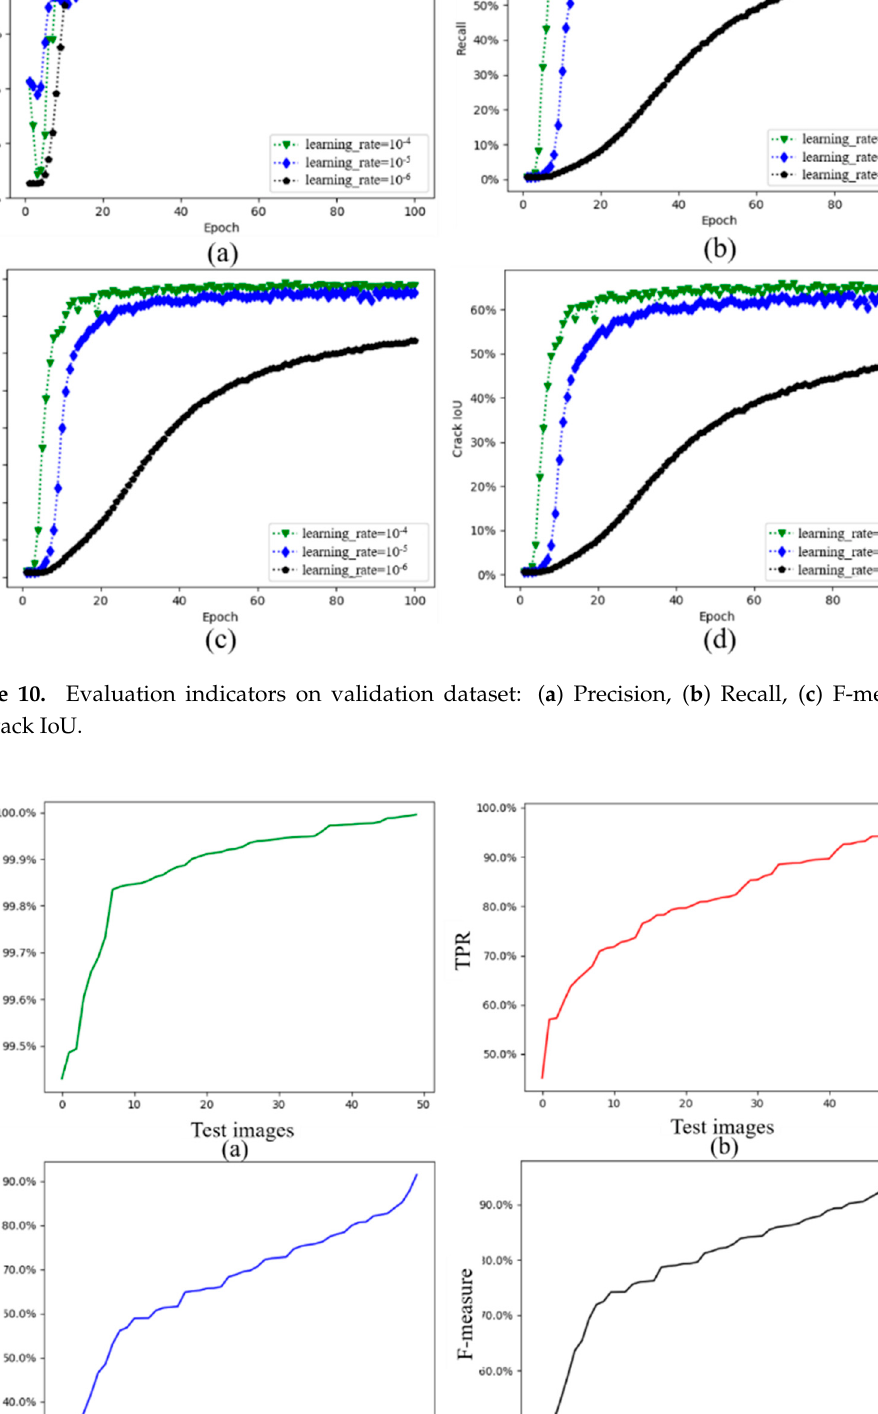
Figure 9. The training losses and validating losses over training epoch: ( a ) learning rate = 10 − 4 , ( b ) learning rate = 10 − 5 , ( c ) learning rate = 10 − 6 .